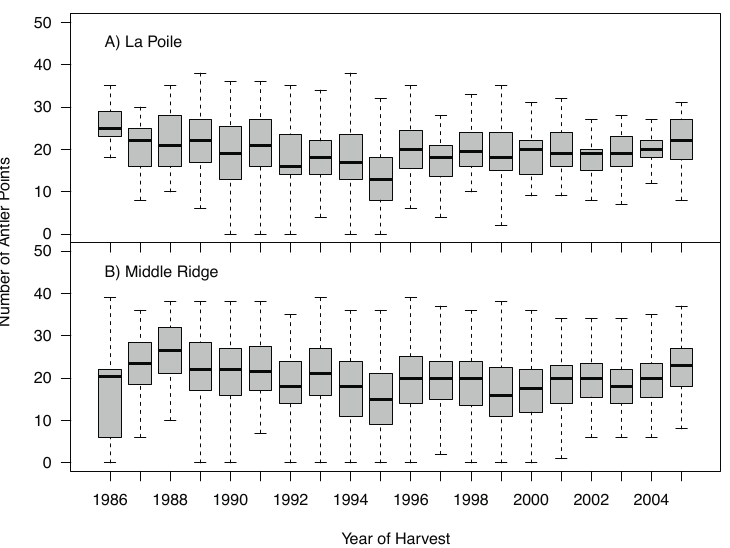
Fig. 2. Annual trends in the number of antler points for prime aged males (≥5 years) in the A) La Poile and B) Middle Ridge herds, 1986 to 2005. The boxes contain the 25th to 75th percentiles of the data and the horizontal line indicates the median. The whiskers extend to 1.5 times the inter-quar- tile